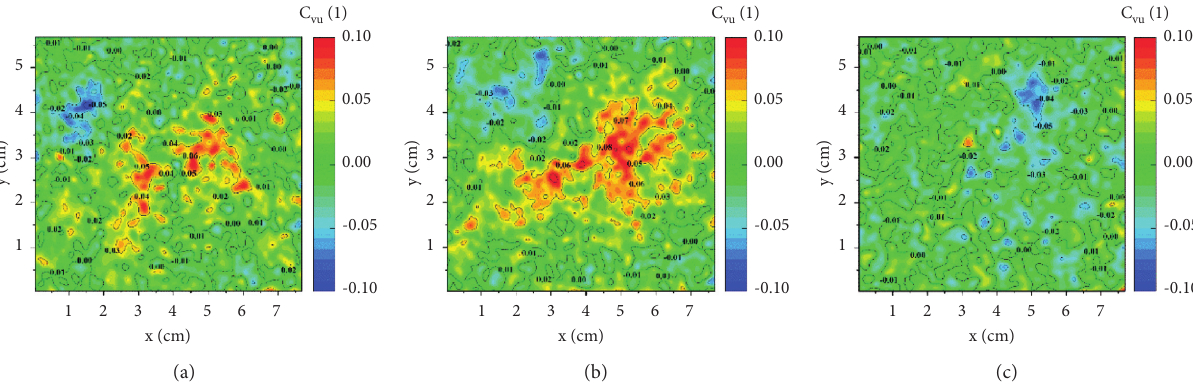
Figure 10: The distribution of C vu in different working conditions. (a) B25S. (b) B25M. (c)